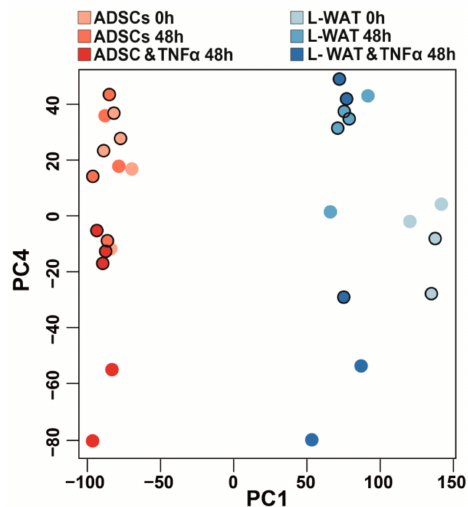
Figure 3. Principal Component Analysis (PCA) of L-WAT and ADSCs. The PCA revealed a clear separation of L-WAT (blue dots) and ADSCs (red dots) along the main component PC1. In addition, TNF α treatment showed a separation along PC4, with a more homogeneous response of ADSCs (dark-red dots), when compared to L-WAT (dark-blue dots). There was no clear clustering of samples from the abdomen (black border) or the thighs (no border).